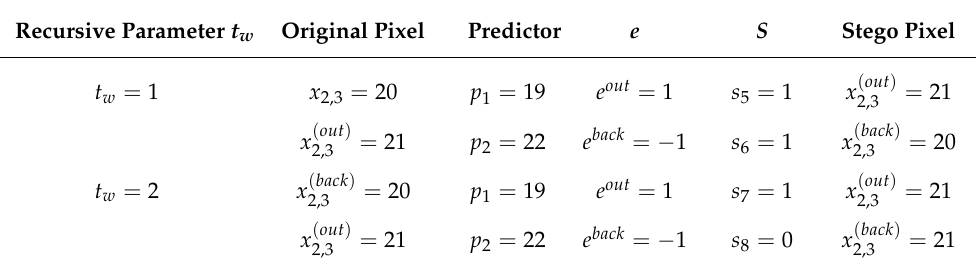
Table 3. White pixel value and the changes of various values in the embedding procedure. Recursive Parameter t